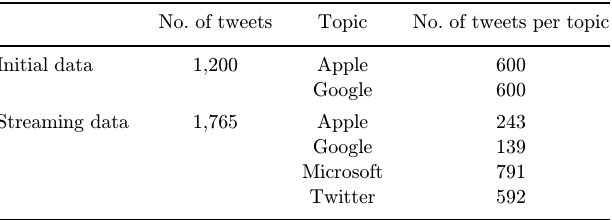
Table 1. Sanders